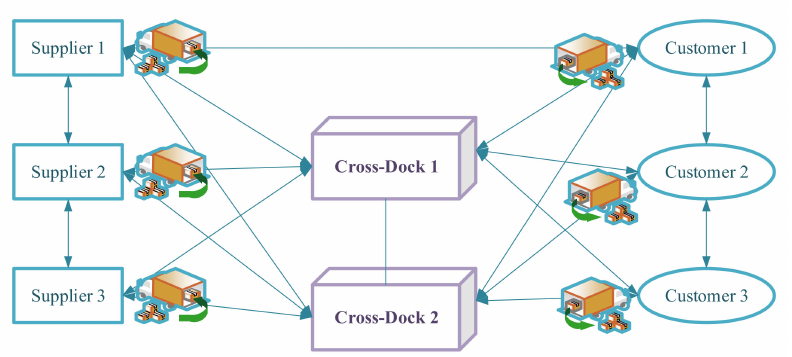
Figure 1. Operation process in the